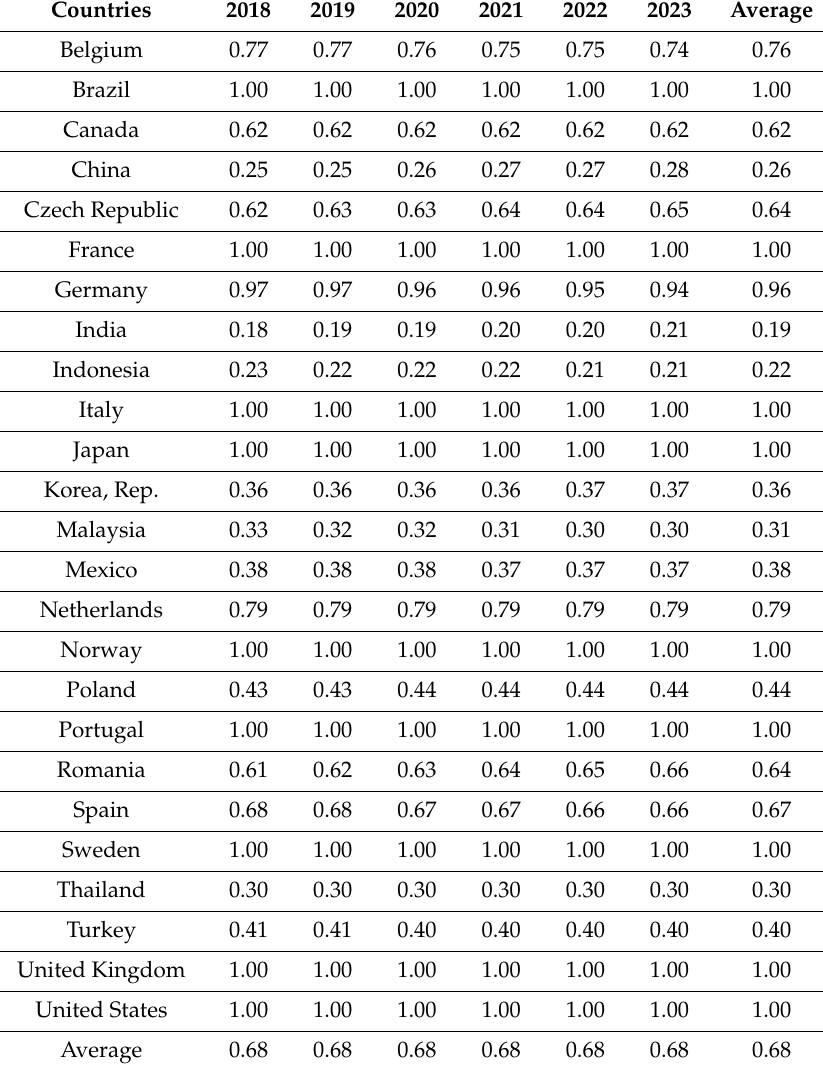
Table 3. E ffi ciency scores from 2018 to 2023.